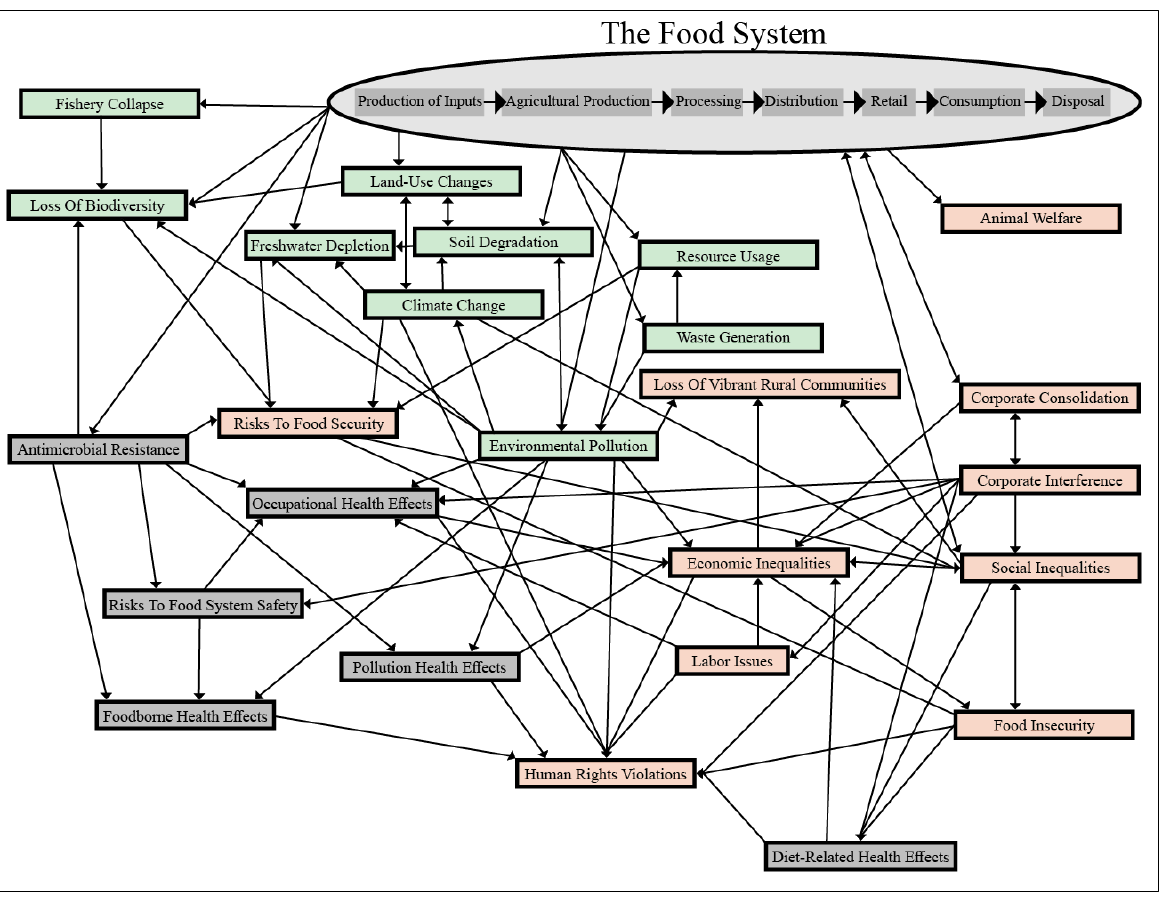
Figure 4. Sustainability Outcomes Map of the U.S. Food System Connections are based on the reviewed literature, with arrows representing the direction of outcome. The colors represent the organizational structure; green is environmental outcomes, grey is health outcomes, and orange is socio-economic